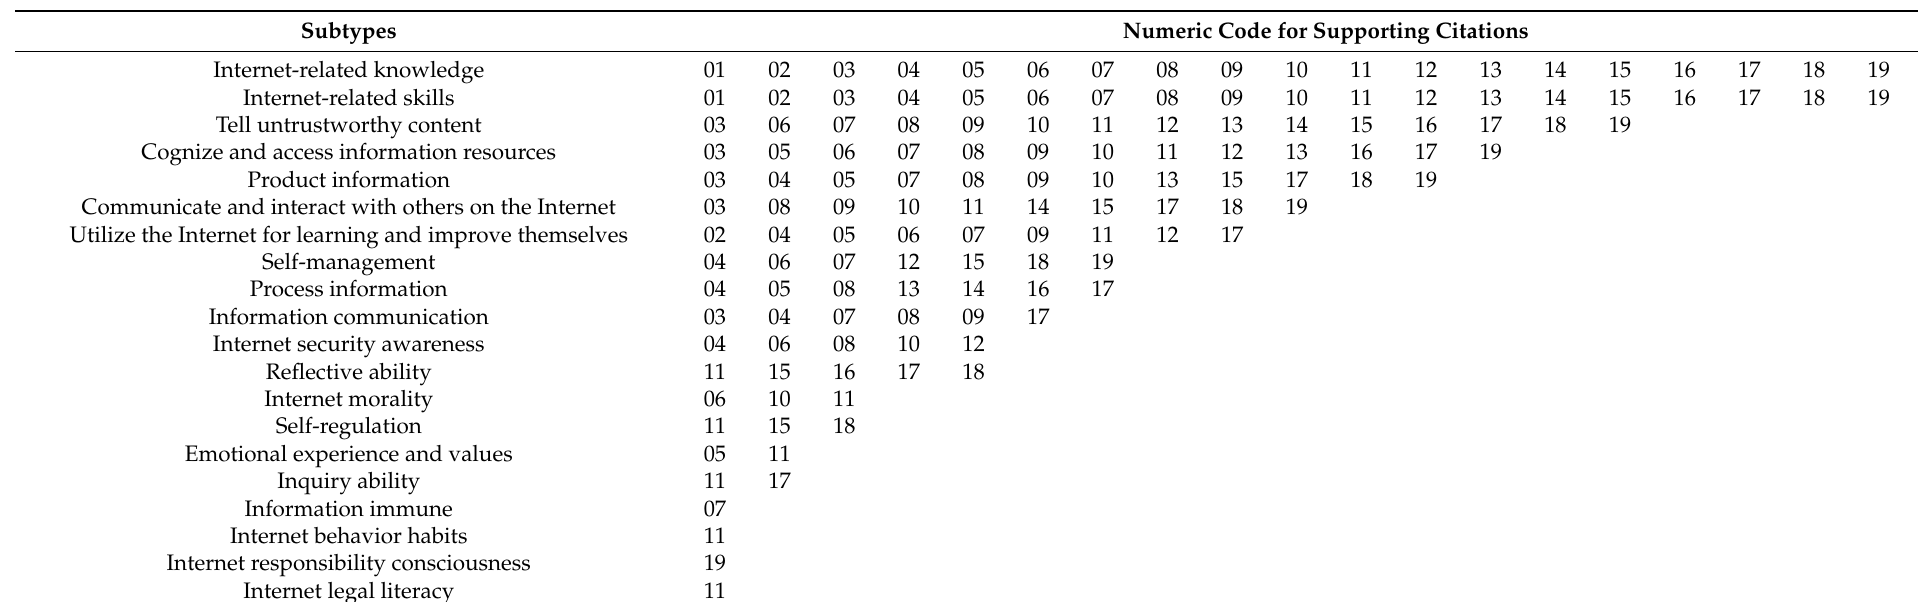
Table 1. Stem-and-leaf plot of literature supporting different subtypes of Internet